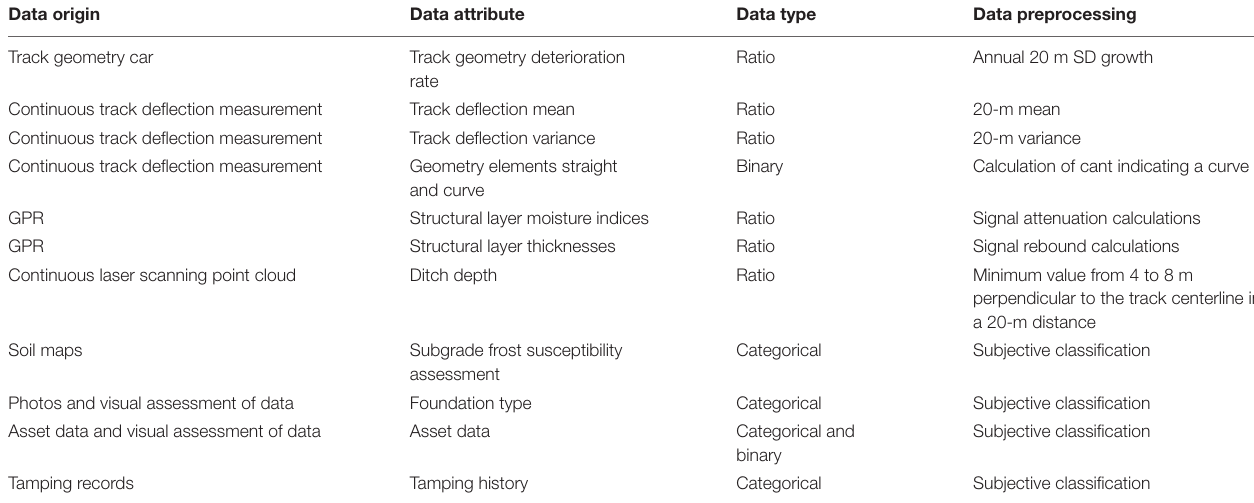
TABLE 1 | Attributes used in data